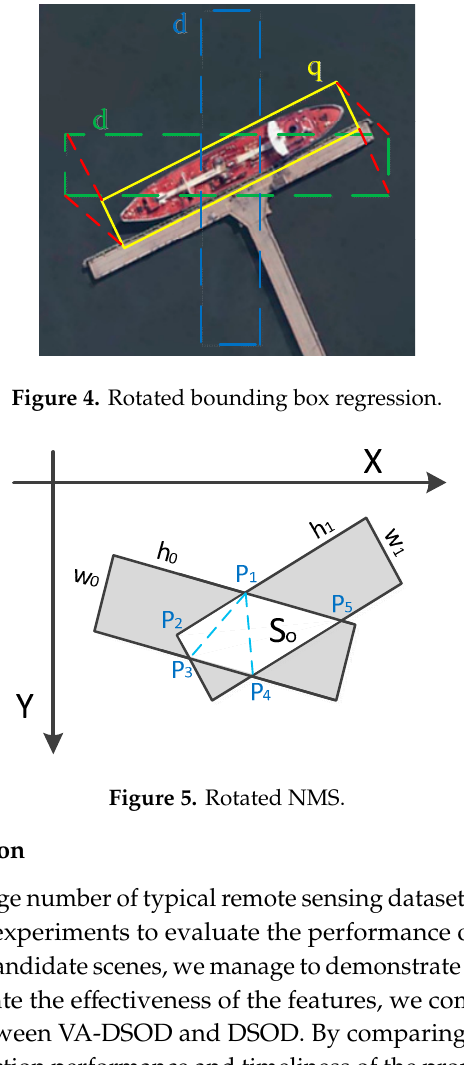
Figure 5. Rotated Figure 5. Rotated NMS.